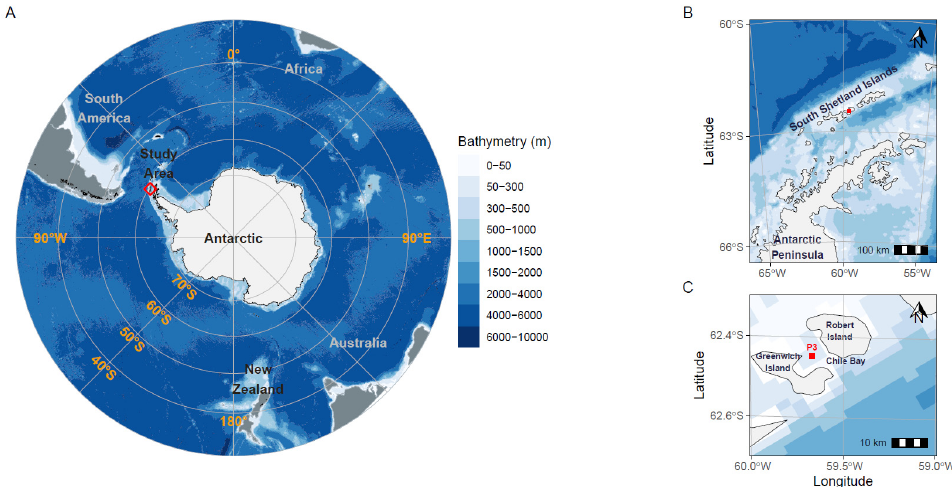
Figure 1. Geographic location of Chile Bay on Greenwich Island, Western Antarctic Peninsula (WAP). The red square ( A – C ) represents the P3 sampling point in the bay where seawater was collected to measure environmental variables and N 2 fixation and carbon assimilation rates.